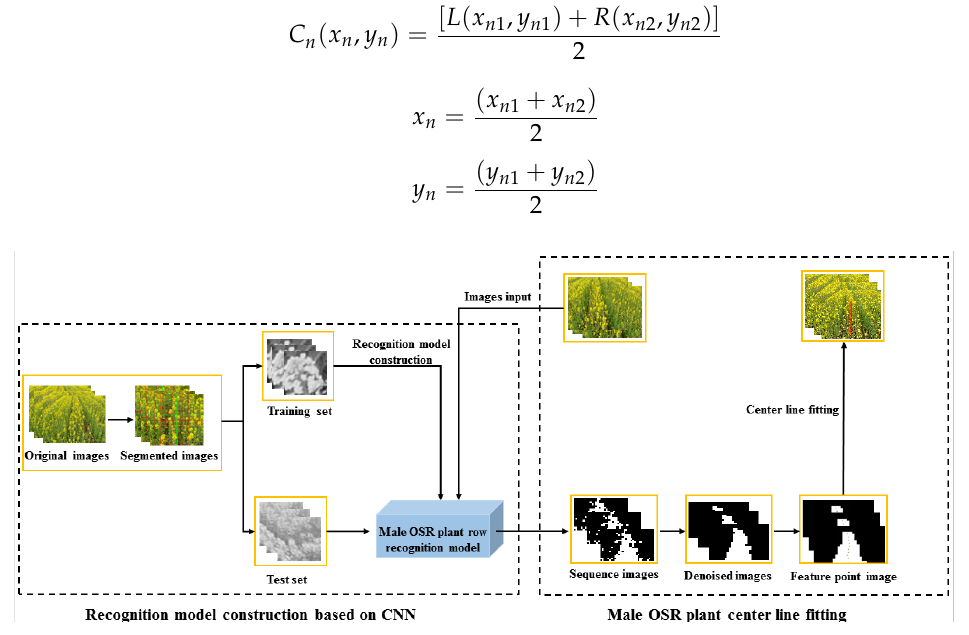
Figure 3. The workflow for OSR plant recognition model construction and center line fitting. The male OSR plant row center lines were fitted using the least-squares method